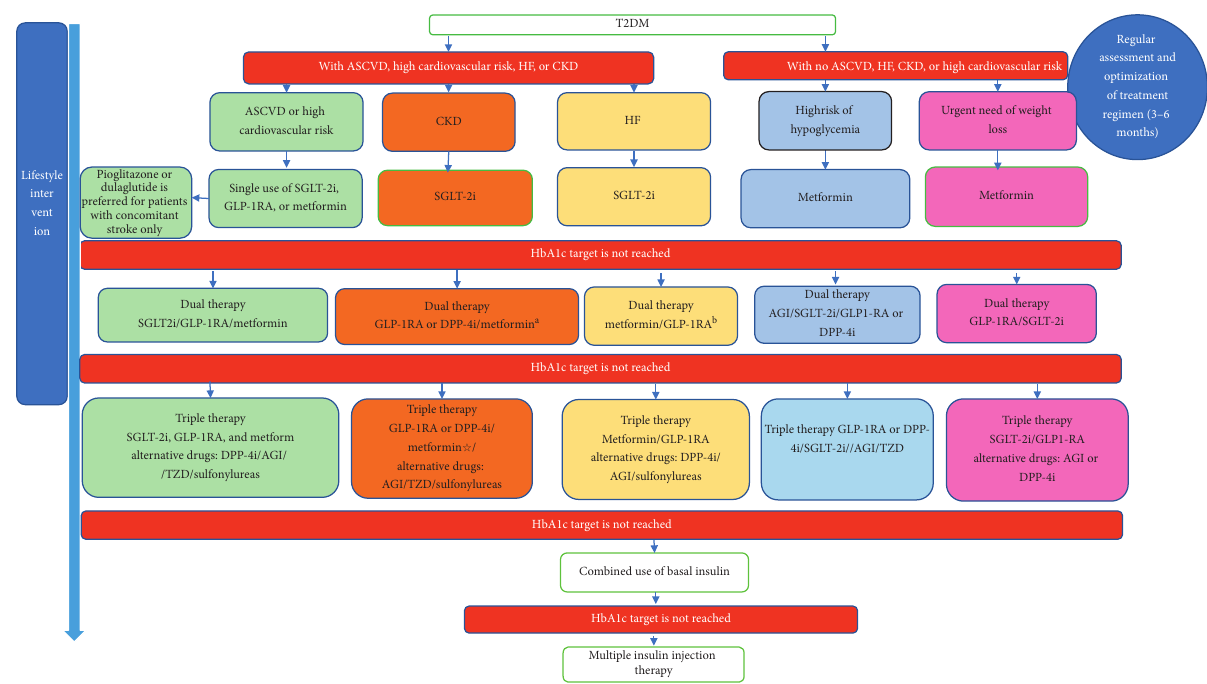
Figure 1: Flowchart of drug therapy for type 2 diabetes mellitus. T2DM: type 2 diabetes mellitus; ASCVD: atherosclerotic cardiovascular disease; HF: heart failure; CKD: chronic kidney disease; GLP-1RA: glucagon-like peptide-1 receptor agonist; SGLT-2i: sodium-glucose cotransporter-2 inhibitor; DPP-4i: dipeptidyl peptidase-4 inhibitor. (a) If patients have an estimated glomerular filtration rate (eGFR) < 45mL/min/1.73m 2 , use of SGLT-2is and metformin is not recommended; it is suggested to select GLP-1RAs or DPP-4is, which have evidence of renal benefits. (b) For patients with T2DM who have HF, the use of SGLT-2is and metformin is not recommended with eGFR < 45mL/min/1.73 m 2 ; it is preferable to use GLP-1RAs, which have evidence of cardiovascular